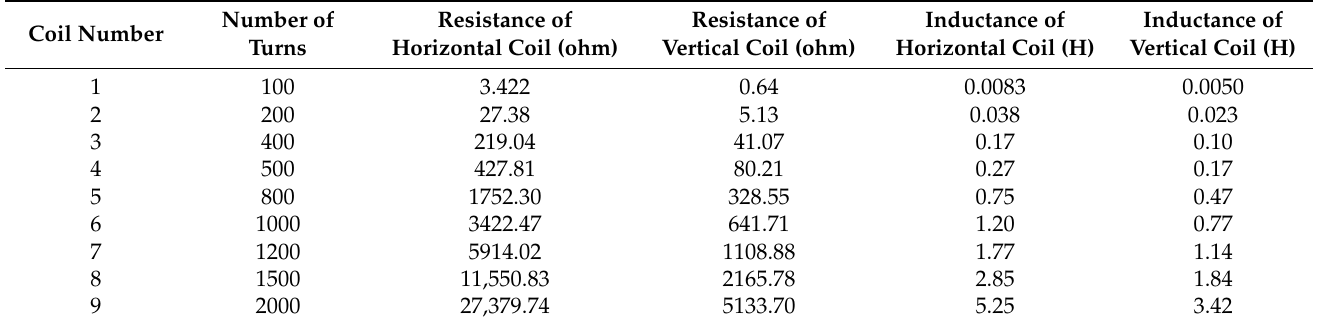
Table 4. Summary of properties of coils for L = 10 cm